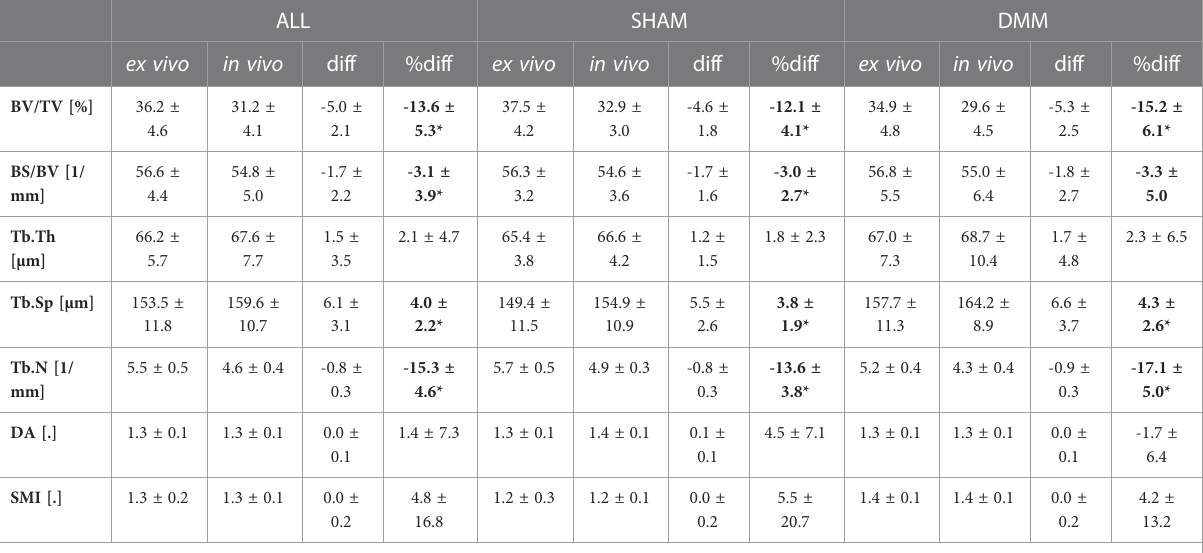
TABLE 3 Trabecular parameters measured in the lateral compartment with in vivo and ex vivo microCT for the pooled (ALL) data and for each group (SHAM or DMM). ALL SHAM DMM ex vivo in vivo diff %diff ex vivo in